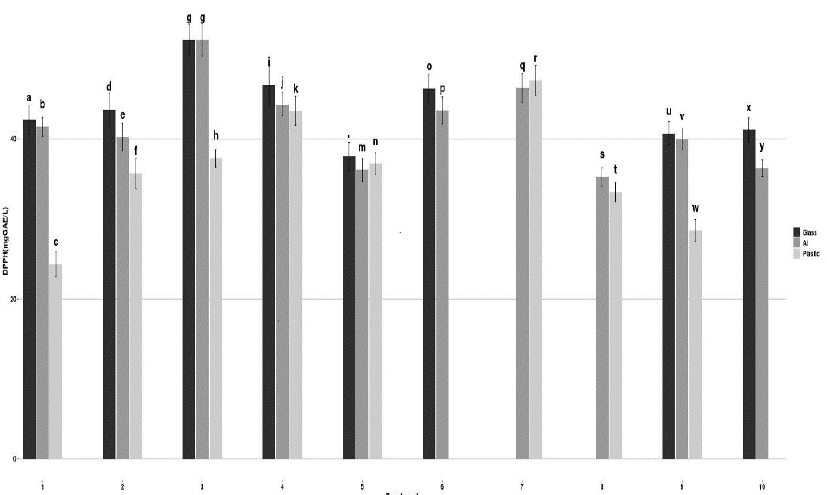
Figure 2. DPPH radical scavenging activity (mg GAE/L) for 10 beer brand and for three packing materials: glass, aluminium and plastic. Vertical bars above each column represent the standard deviation of triplicate determinations. Different letters indicate differences ( p < 0.05) between the samples.